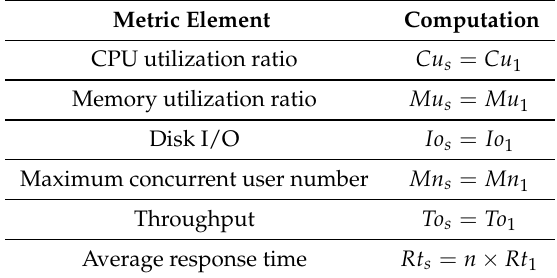
Figure 5. The Loop relationship. Table 7. The computation of the loop relationship